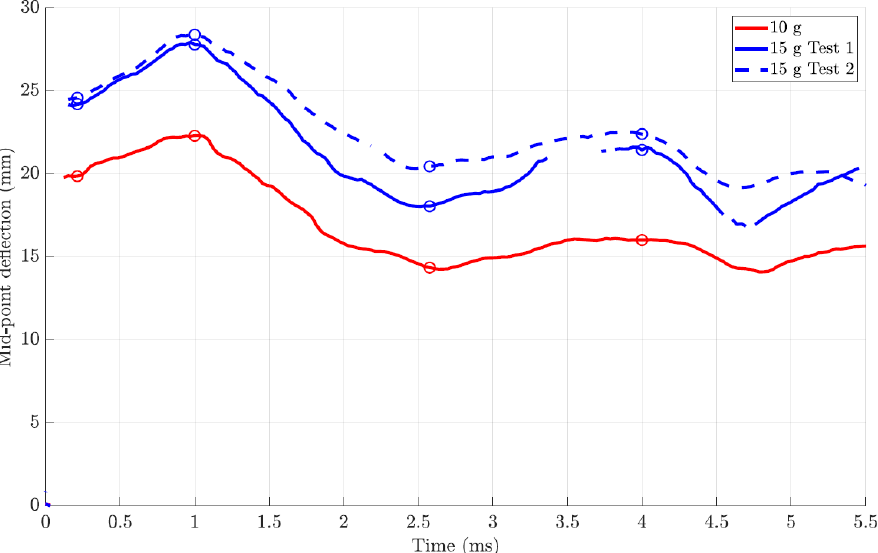
Figure 13. Graph of transient midpoint displacement vs. time obtained from blast tests on 120 ◦ V-structures, 32 mm tip radii. Circles indicate the discrete times for the selected deformation